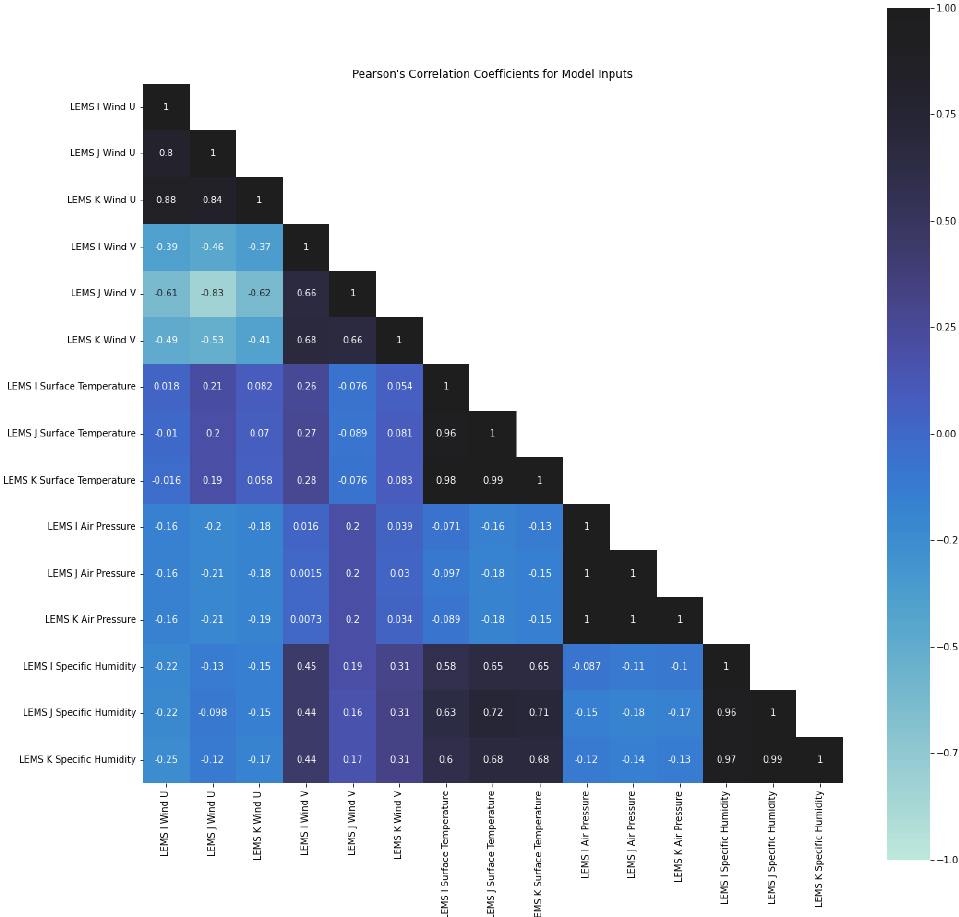
Figure A5. Pearson’s R correlation coefficients between the input variables when predicting specific humidity. Further discussion can be found in Appendix